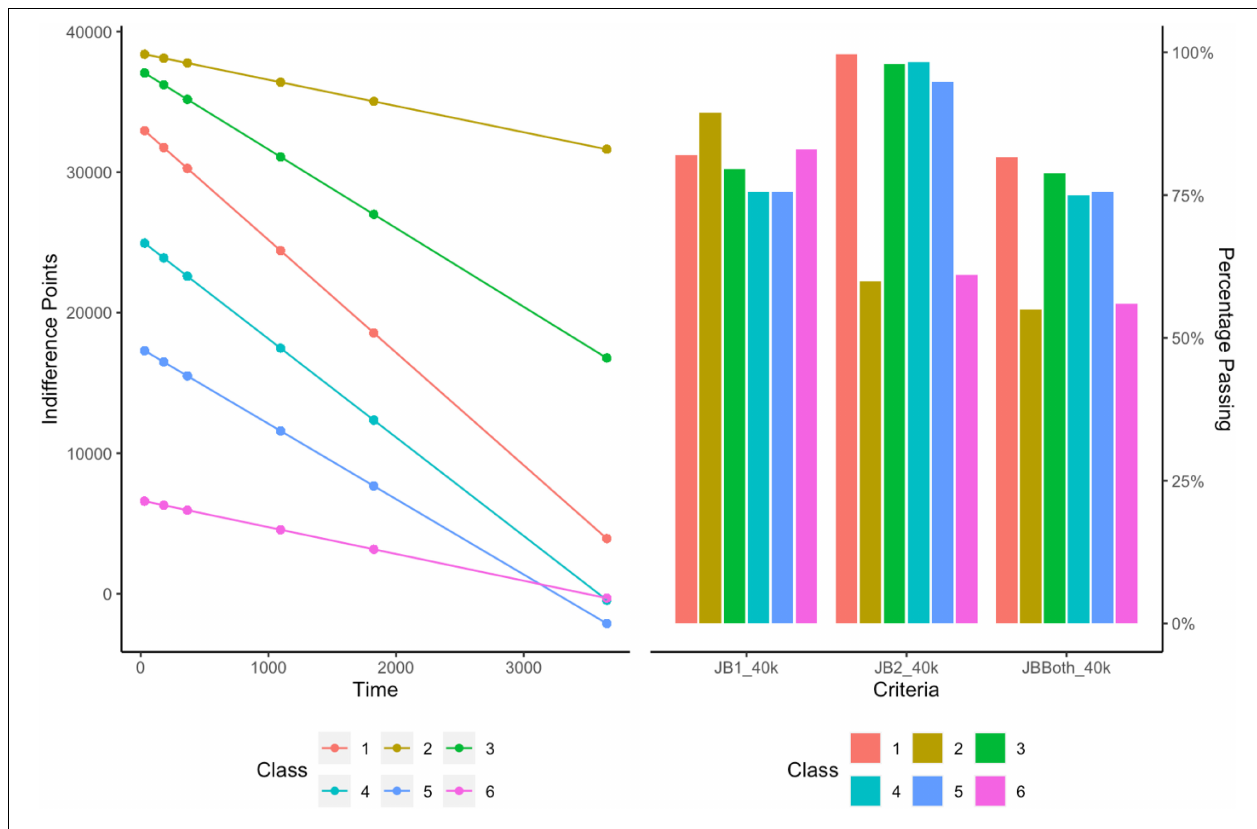
FIGURE 3 | Latent class analysis and systematic criteria of high magnitude task